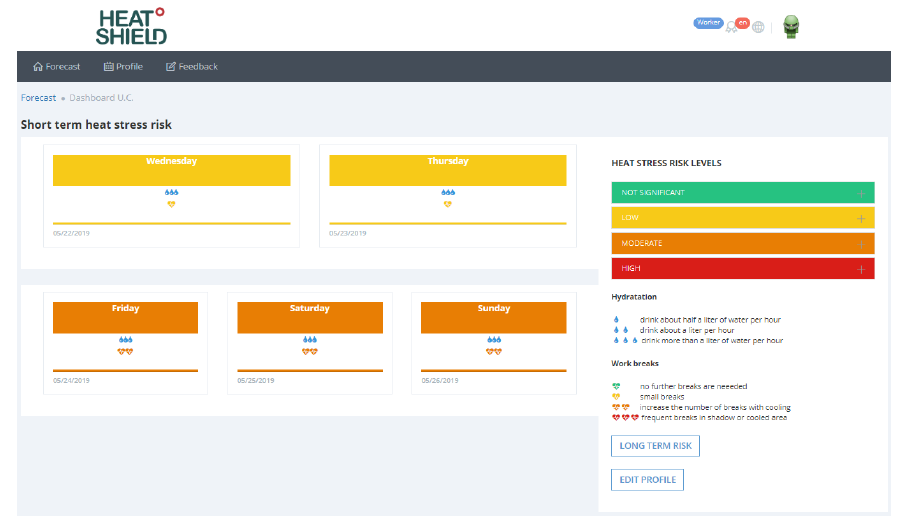
Figure 5. Worker’s heat stress risk and behavioral suggestions to be taken in the short term (the first 5 days of forecasting the heat stress risk of the HEAT-SHIELD platform) available in the own profile of the personalized heat stress warning.